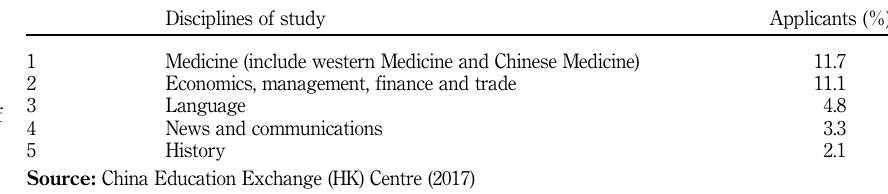
Table V. Popular disciplines of